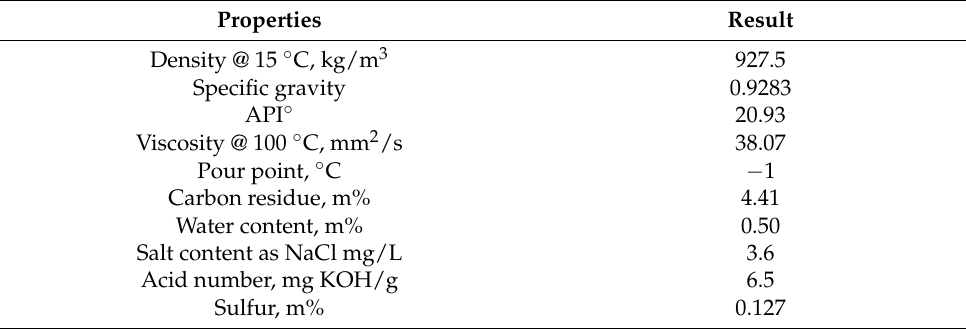
Table 1. The properties of Al-Fula crude